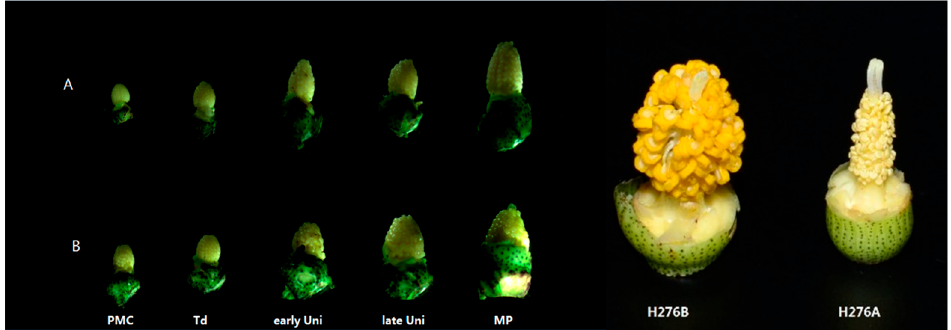
Figure 1. Phenotype of the floral buds of the cytoplasmic male sterility (CMS) line H276A and its maintainer H276B: ( A ): CMS line H276A; ( B ): Maintainer line H276B. Notes: PMC, pollen mother cell stage; Td, tetrad stage; early Uni, early uninucleate; late Uni, late uninucleate; MP, mature pollen stage.